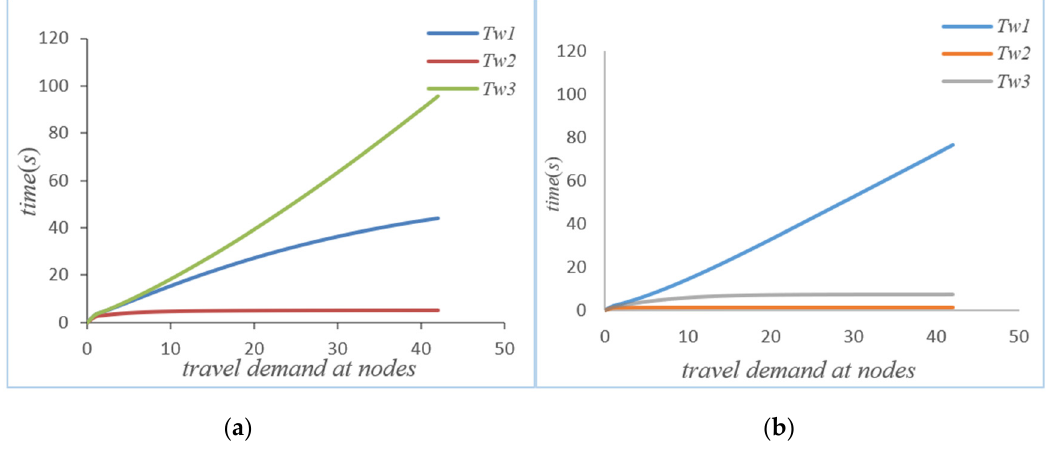
Figure 3. ( a ) Waiting time without self-balancing; ( b ) waiting time with self-balancing. As can be seen from Figure 3a,b, if the autonomous vehicle in the system adopts a self-balancing strategy, not every node average waiting time will be reduced. However, from the perspective of the system, it can be seen that the waiting time of node 1 has increased, but the waiting times of node 2 and node 3 are significantly reduced after the autonomous vehicle self-balancing. According to Figure 7, the average waiting time of the system has been significantly reduced after the self-balancing of the autonomous vehicle. Figure 4a,b compare the changes of queue length at nodes before and after the self-balancing of autonomous vehicles in the system under the same travel demand. The horizontal axis represents travel demand, and the vertical axis represents queue length.